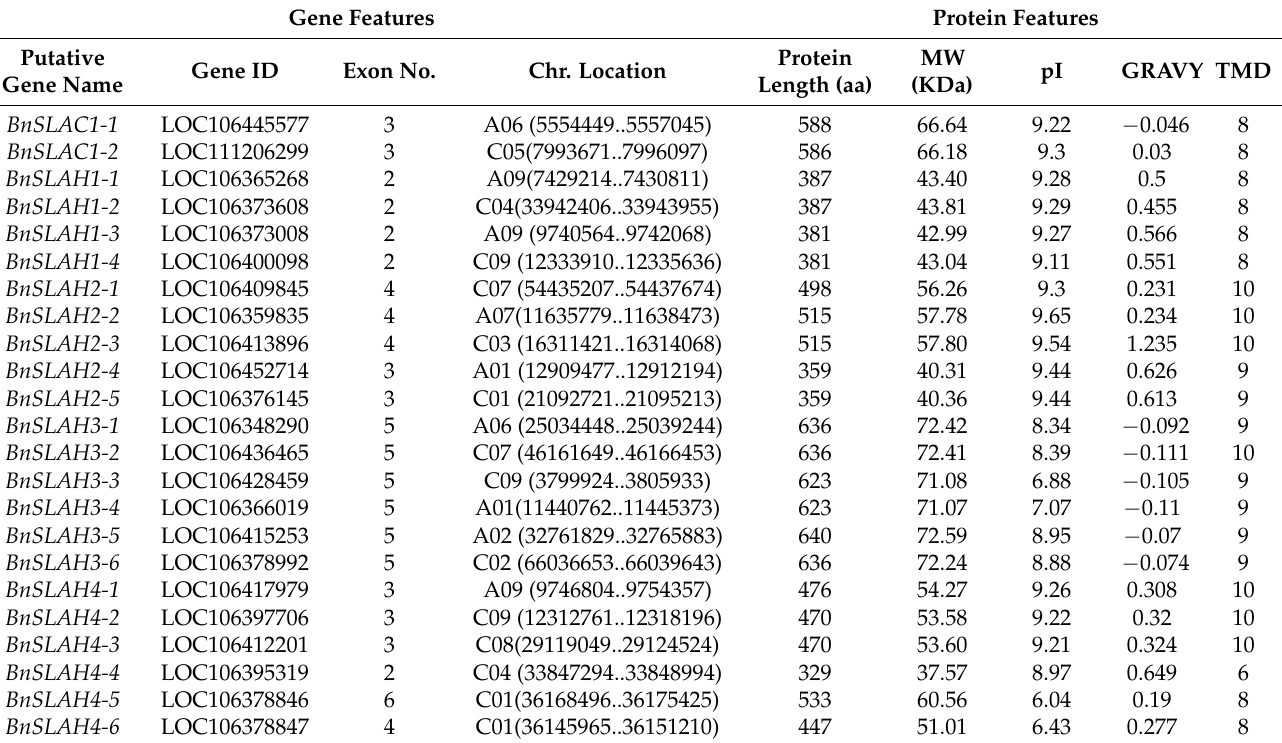
Table 1. Characterization of 23 SLAC/SLAH members identified in B. napus